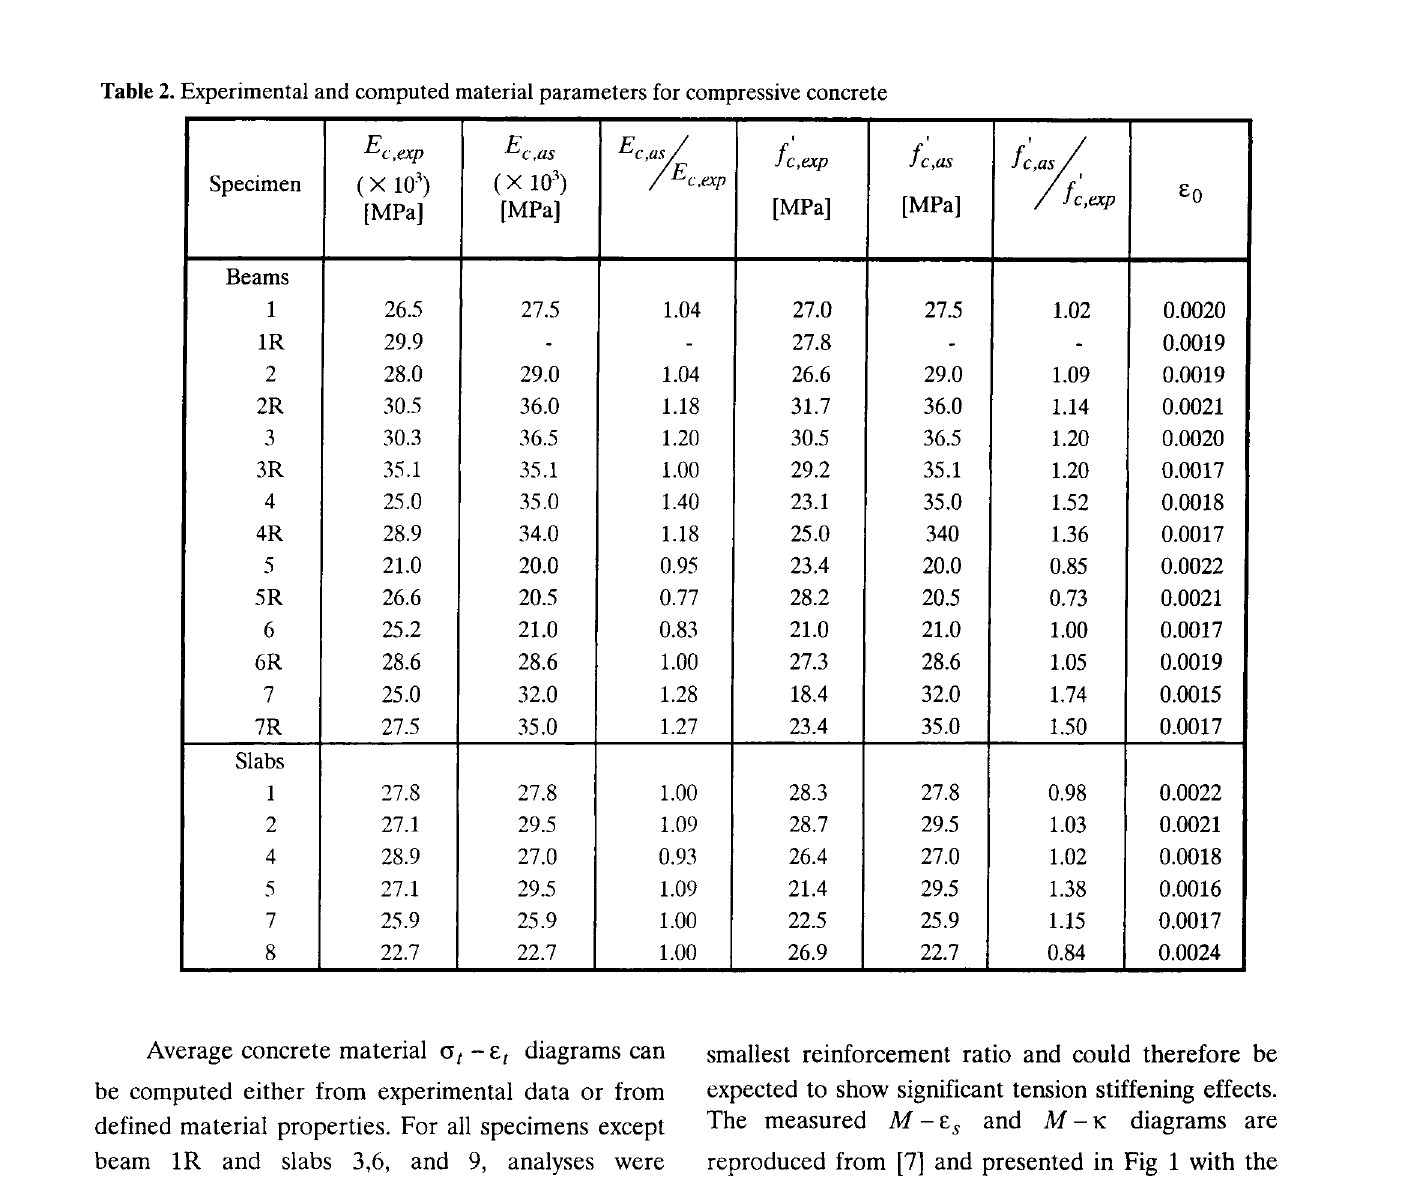
Table 2. Experimental and computed material parameters for compressive concrete